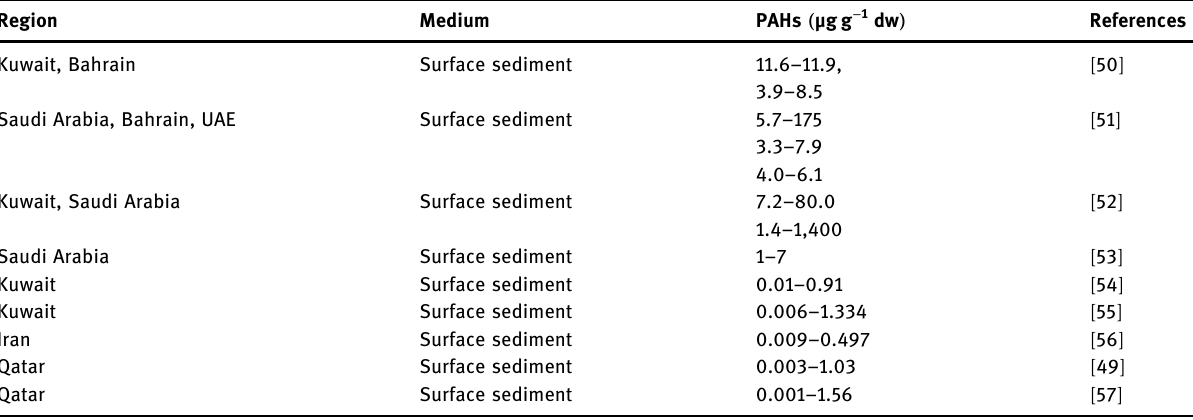
Table 1: The level of PAHs along the Gulf countries Region